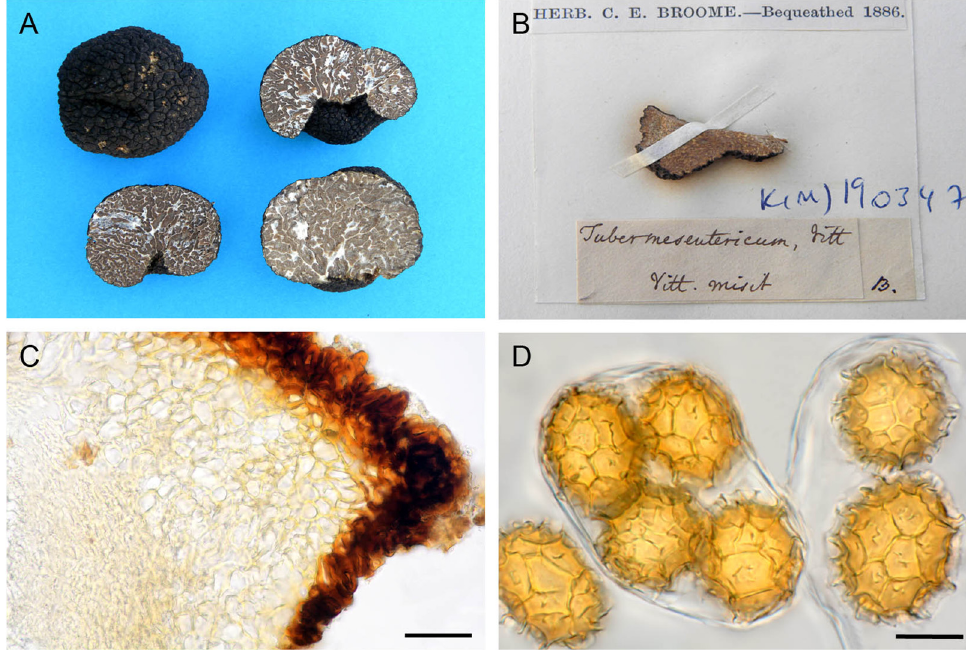
Figure 4. T. mesentericum s.s. ( A ) Ascomata in section (neotype). ( B ) Fragment of the ascoma K(M)190347 from the Kew herbarium identified as T. mesentericum s.s. ( C ) Peridium structure. ( D ) Asci and ascospores. Bars = 20 µm.